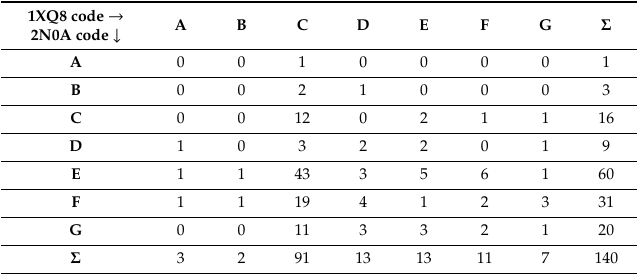
Table 1. Changes in location of structural codes. Rows in the table contain micelle-bound ASyn structural codes, columns—structural codes present in amyloid form (2N0A positions